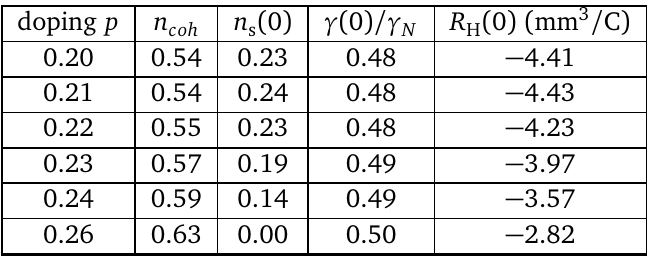
( 0 ) , n ( 0 ) for scenario C in which the incoherent Table 12: Calculated n and R coh s H carriers occupy the nodal regions of the Fermi surface. The large negative Hall co- efficients are clearly inconsistent with the literature. Moreover, the lack of a strong doping dependence in γ ( 0 ) /γ fails to account for the measured residual specific N heat in OD